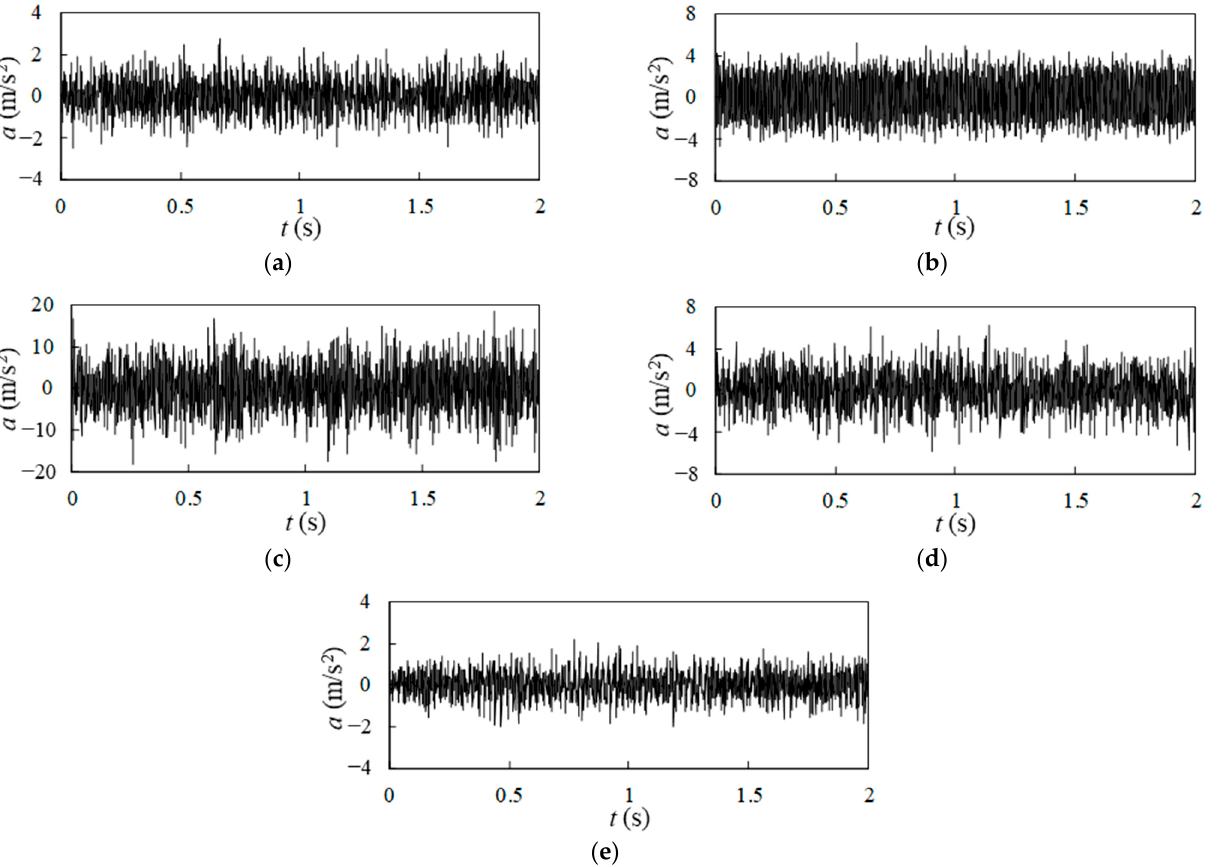
Figure 15. Acceleration response of each measurement point. ( a ) Measurement point 1; ( b ) measurement point 2; ( c ) measurement point 3; ( d ) measurement point 4; ( e ) measurement point 5.